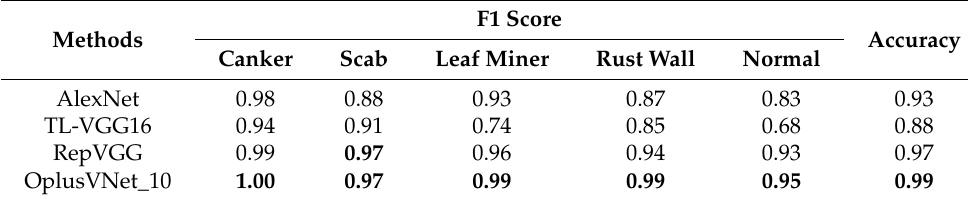
Table 4. F1 score and accuracy rate values of different